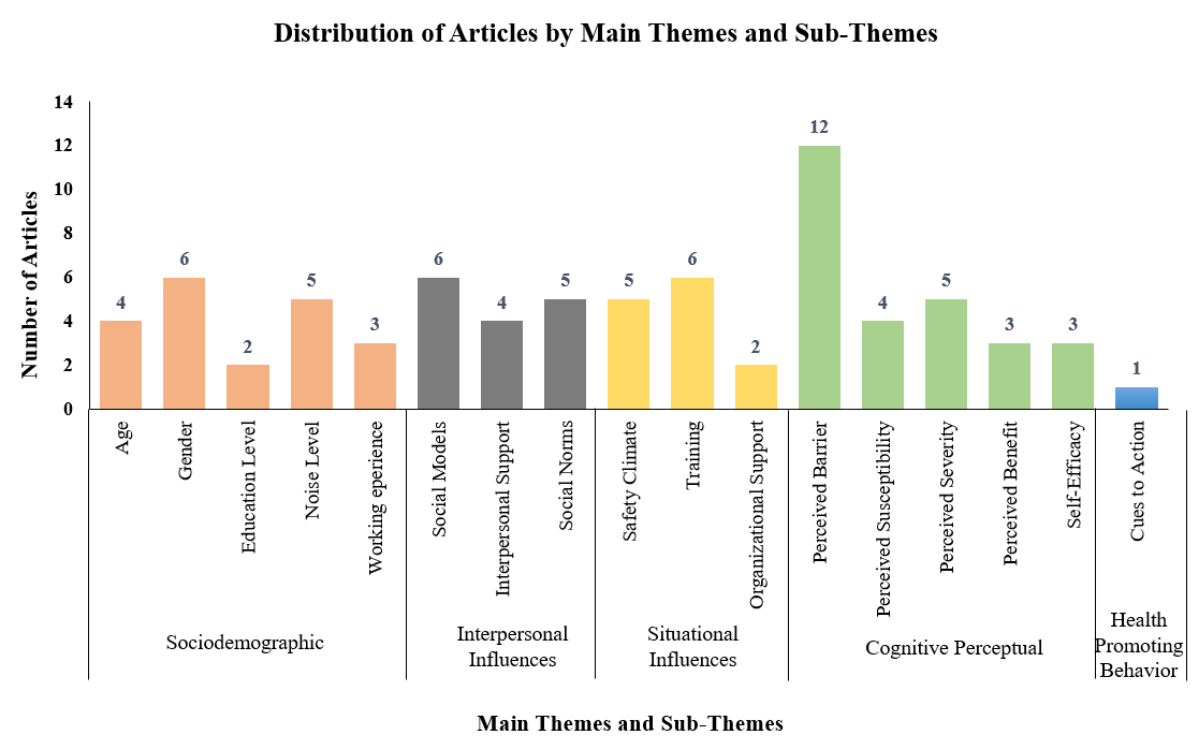
Figure 2. Percentage distribution of themes.